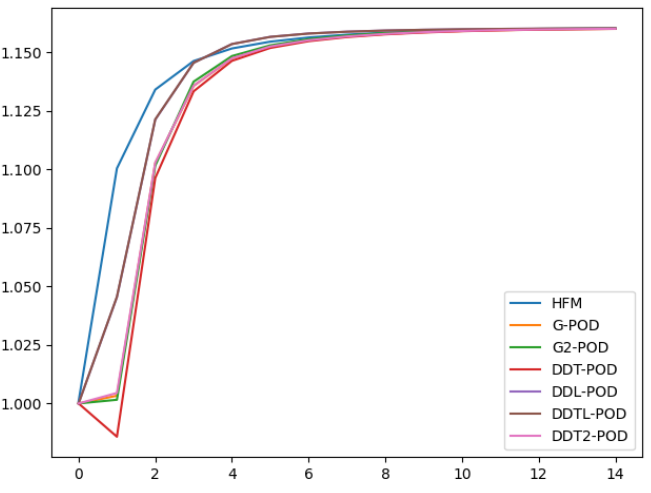
Figure 3. k eff vs. iteration number for all methods and the High-Fidelity Model